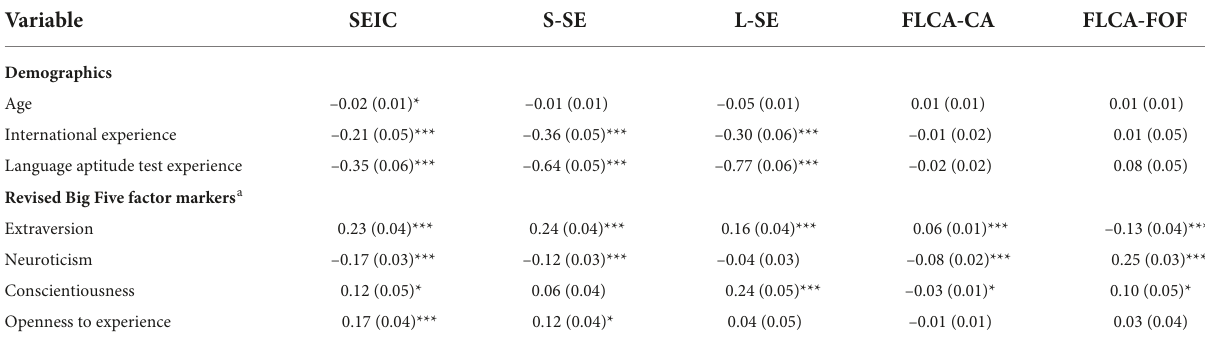
TABLE 3 Results of the supported structural equation model for the relationships between the study variables with emerging adults in Japan ( N = 1,326).